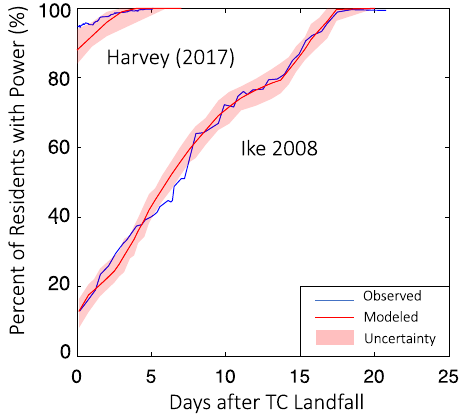
Fig. 1 | Comparison ofthe simulated and observedpower outage and recovery process for Hurricanes Harvey and Ike in Harris County, TX. Red curve shows medianvaluesofthesimulationresults,withthe32to68%quantilerangeshownby shade. Blue curves show the observations of the power